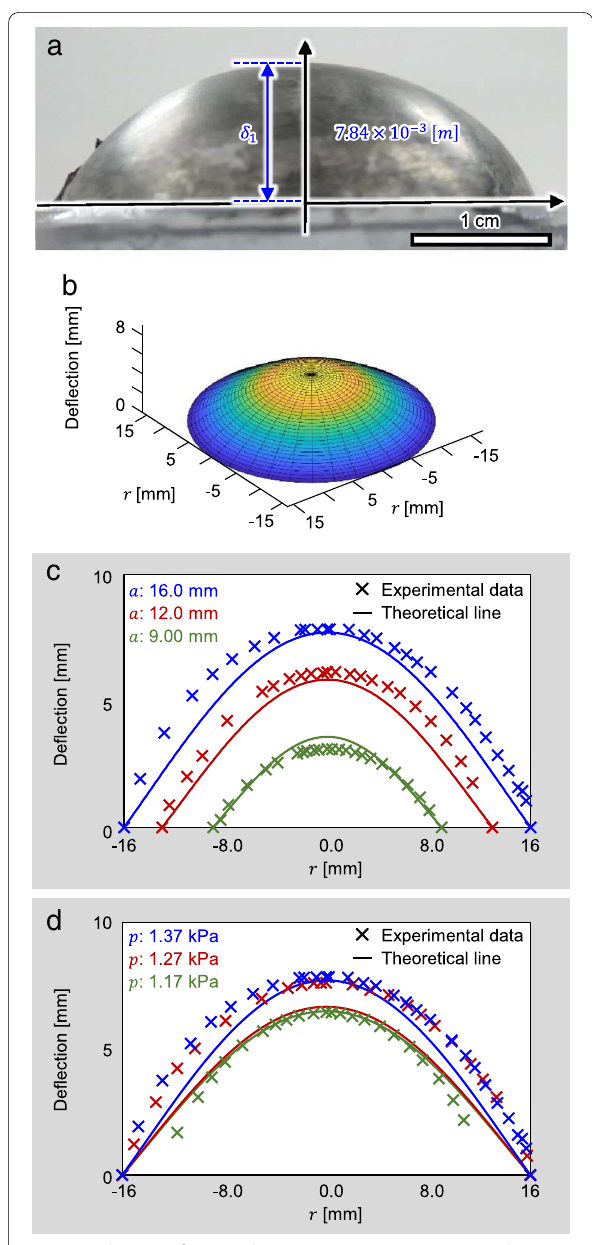
Fig. 5 Evaluation of DEA with water pressure. a Experimental picture of DEA with a water pressure of 1.37 kPa. b 3D plot of the analytical solution of Eq. 23. c Comparison of theoretical and experimental data with changing diameter a . d Comparison of theoretical and experimental data with changing pressure